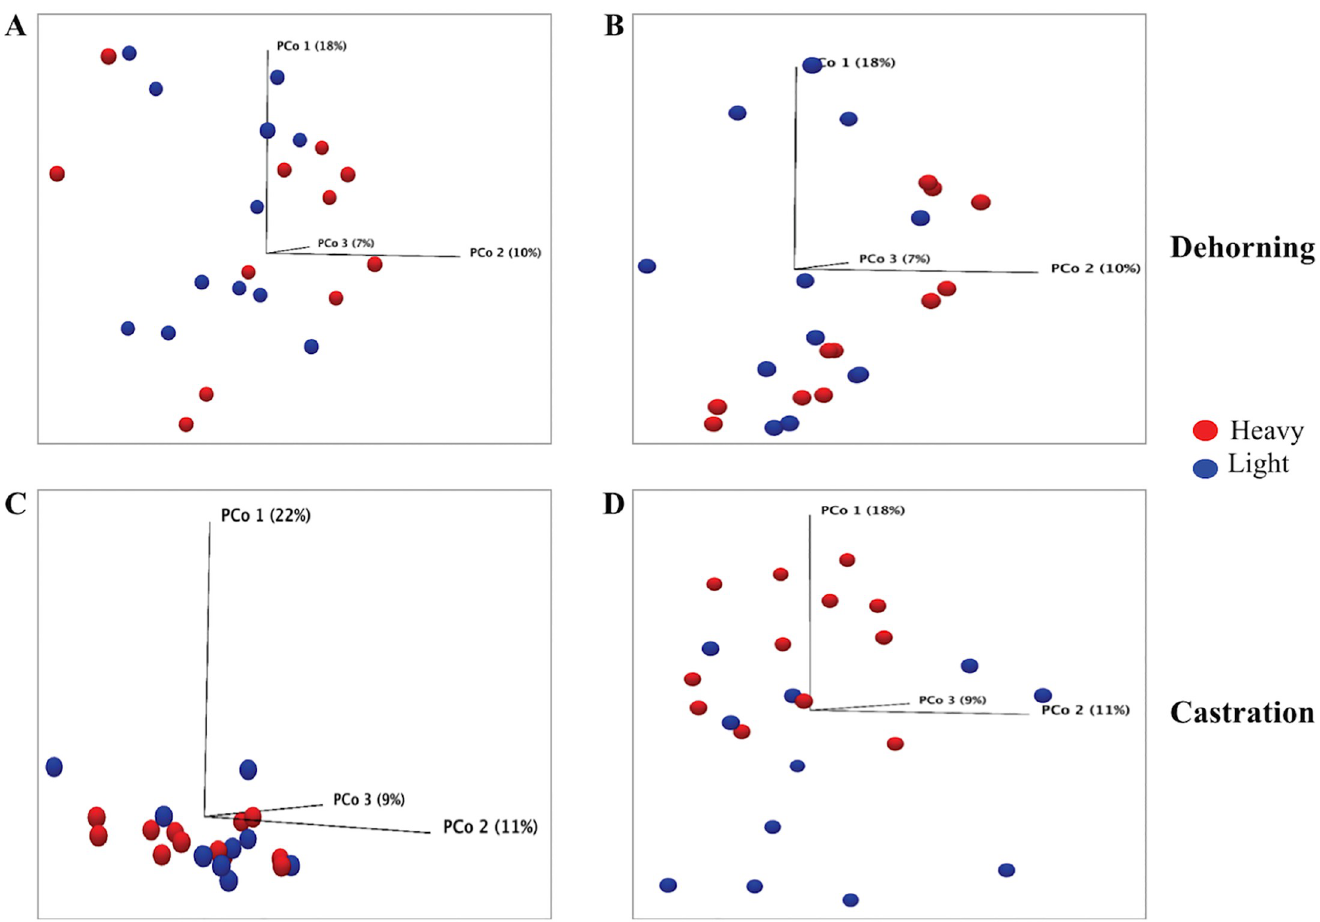
Fig 1. Principal Coordinate Analysis (PCoA) plots for calves, grouped according to body weight, before and after exposure to stress. (A) and (B) represent bacterial diversities in calves before and after dehorning, respectively; (C) and (D) represent bacterial diversities in calves before and after castration, respectively. Each sphere represents one sample. Red spheres represent heavy-weight and blue spheres represent light-weight calves. The input for PCoA was the OTU table containing the rarefied number of sequences observed in each OTU for each sample. The p- value obtained in Bray-Curtis distance comparisons was Bonferroni-corrected and a significance threshold of p -value < 0.05 was used in all statistical